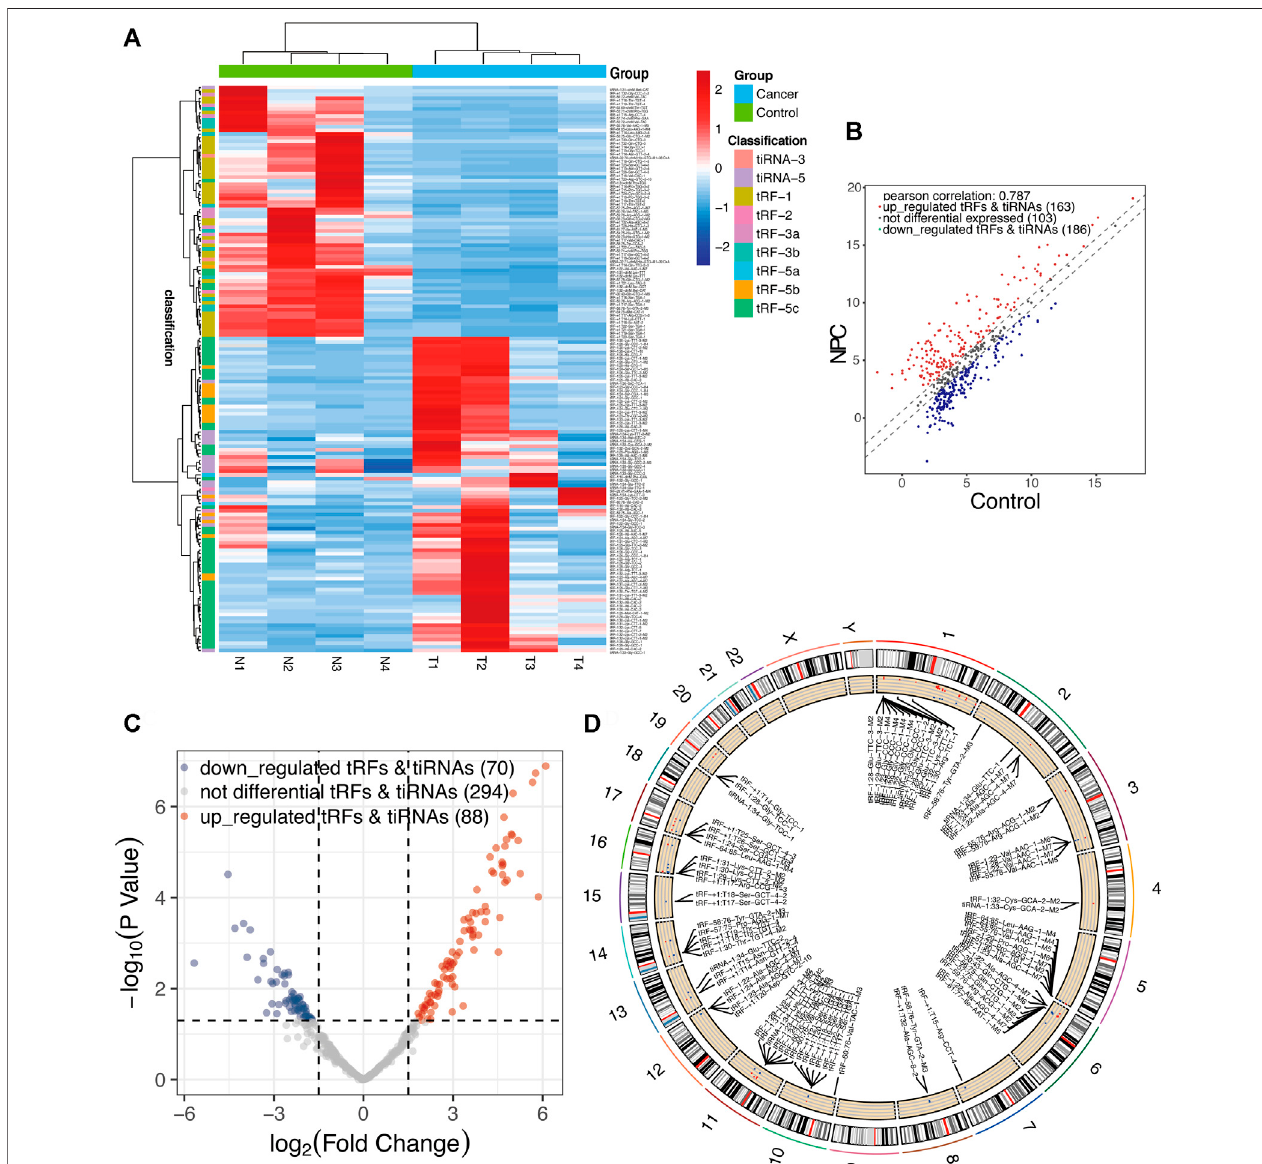
FIGURE 3 | Expression pro fi les of all aberrantly expressed tRFs/tiRNA sequencing data in nasopharyngeal carcinoma and healthy controls. (A) Expression heatmapofallaberrantlyexpressedtRFs/tiRNAs. (B) Scatterplotbetweentwogroups.CPMvaluesofalltRFsandtiRNAsareplotted.Thevaluesofthe X- and Y -axesin thescatterplotaretheaveragedCPMvaluesofeachgroup(log2scaled).tRFsandtiRNAsabovethetopline(reddots,upregulation)orbelowthebottomline(bluedots, downregulation)indicatemorethan1.5-foldchangebetweentwocompared groups.Graydotsindicatenon-differentiallyexpressed tRFsandtiRNAs. (C) Volcano plot presents differential expression between the two groups. The values of the X- and Y -axes in the volcano plot are log2 transformed fold change and -log10 transformed p -values between the two groups, respectively. Red/blue circles indicate statistically signi fi cant differentially expressed tRFs and tiRNAs with a fold change of no less than 1.5 and p -value # 0.05 (red, upregulated; blue, downregulated). Gray circles indicate non-differentially expressed tRFs and tiRNAs, with FC and/or q-value that are not meeting the cut-off thresholds. (D) Circos plot of all differentially expressed tsRNAs on human chromosomes (visualize only part of the